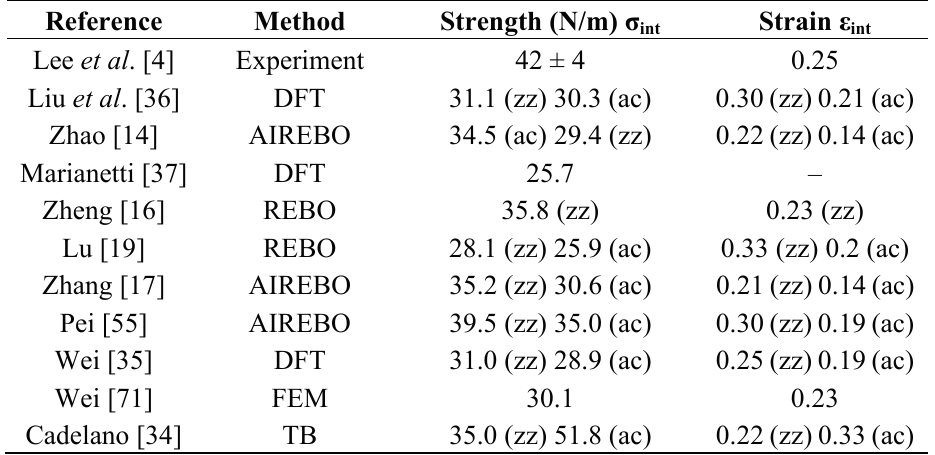
Table 2. The intrinsic strength (the second-order Piola-Kirchhoff stress) and the corresponding Lagrange strain of graphene monolayer.